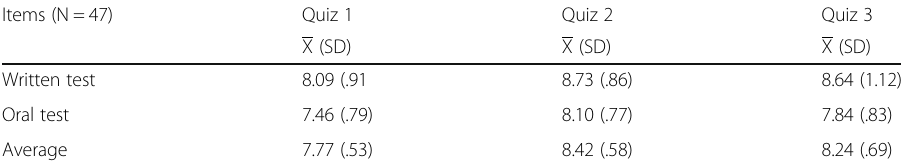
Table 4 EFL learners ’ LC - Formative